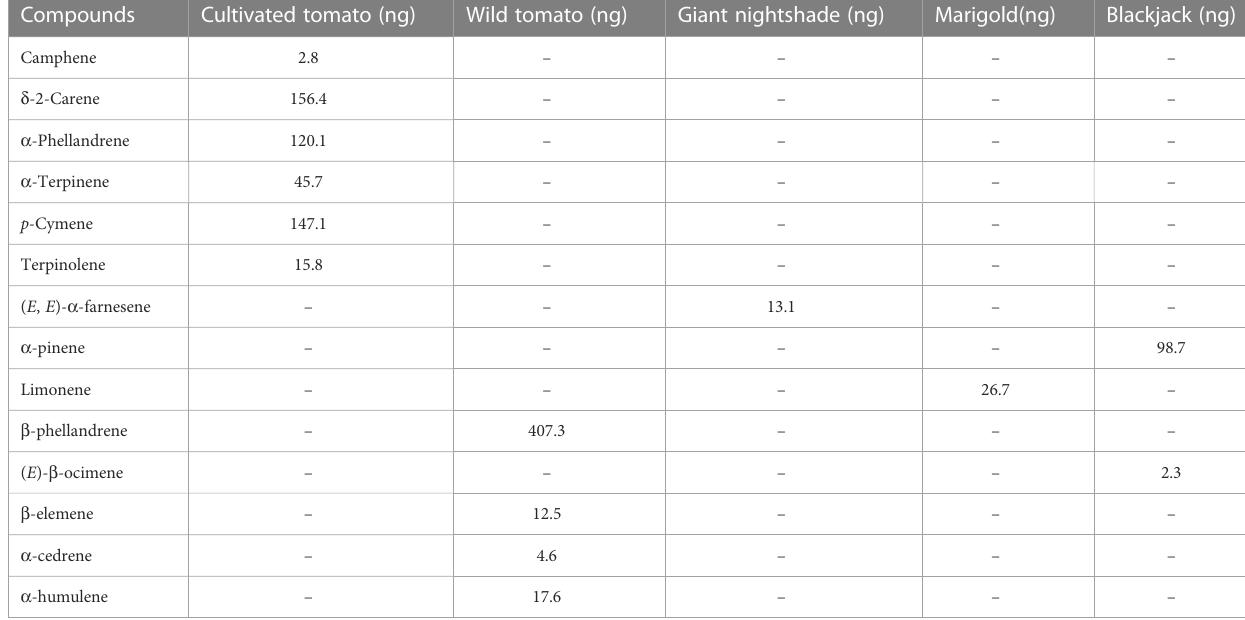
TABLE 1 Sources of most discriminating compounds in intact plant volatiles selected for formulating synthetic